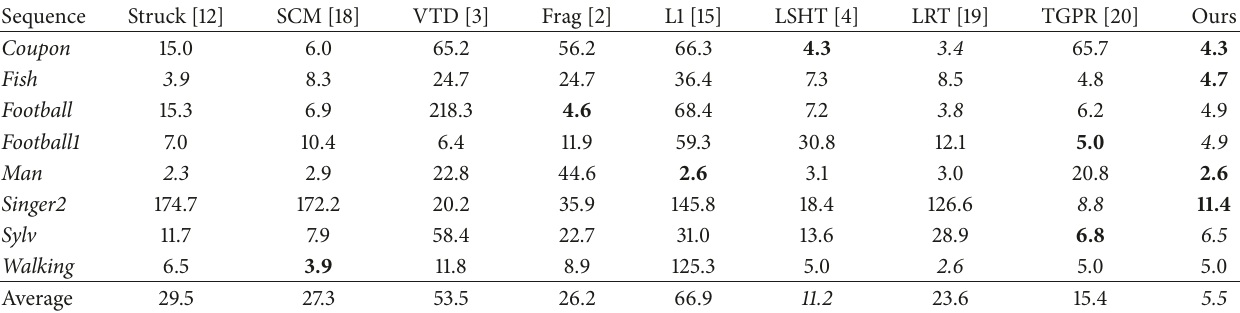
Table 3: Average center location errors (in pixels). The best two results are shown in italic and bold colors, respectively. Sequence